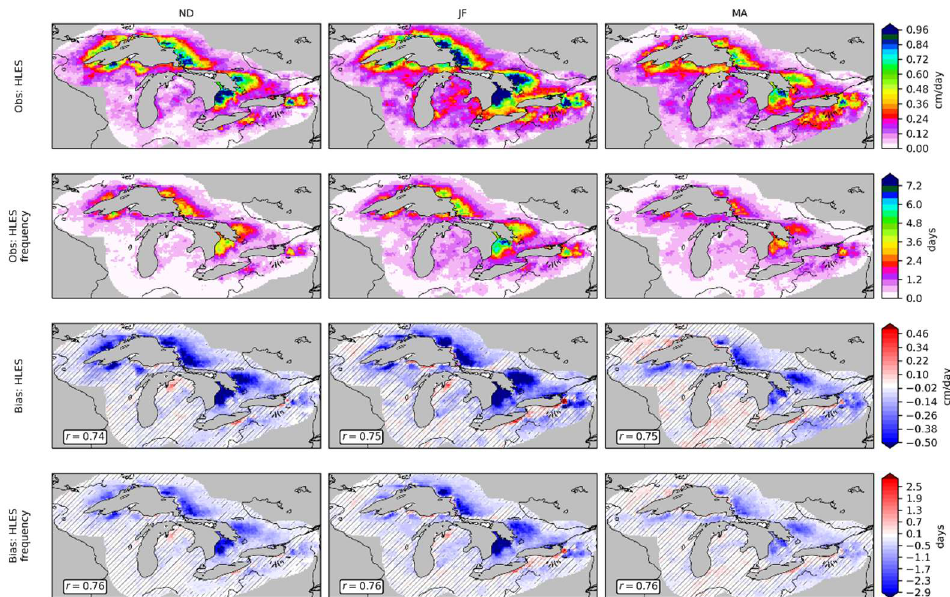
Figure 3. Observed fields (upper rows) and corresponding biases (lower rows) in the GEM_NEMOc simulated mean climatologic HLES (cm/day) and HLES frequency (days) for the November–December (ND), January–February (JF), March–April (MA) periods of the 1989–2010 period. Biases not significant at 10% significance level are hatched. Biases are not shown for the Great Lakes due to lack of reliable observation data.